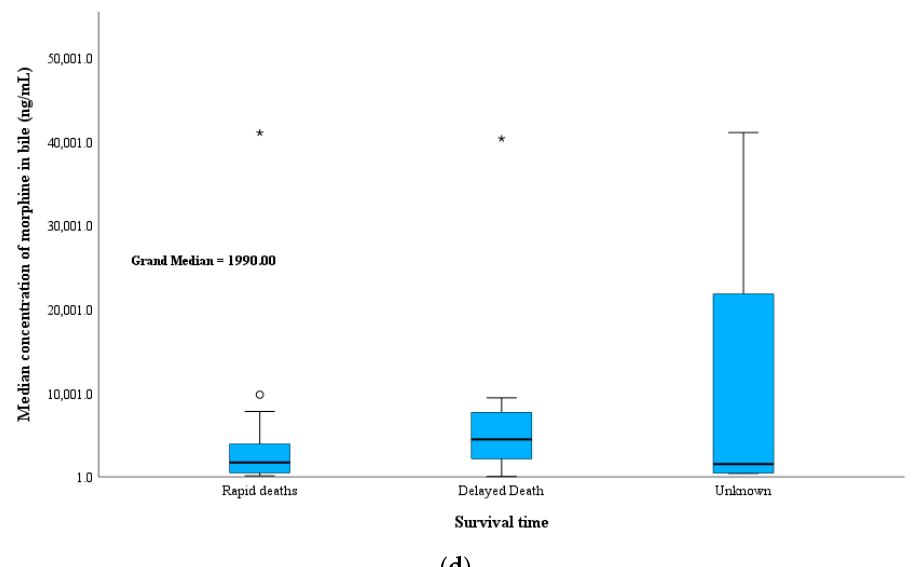
Figure 5. Variation of median morphine concentration in the 97 heroin-related fatalities cases ac- cording to survival time before death; ( a ) blood with sodium fluoride (ng/mL), ( b ) urine (ng/mL), ( c ) vitreous humor and ( d ) bile. The whiskers correspond to the smallest and largest value within 1.5 times the interquartile range, and circles (outlier) symbolize values exceeding at least 1.5 times the interquartile range and extremes (asterisks) correspond to values exceeding at least 3.0 times the interquartile range (this description is applied to the remaining box-plot figures).